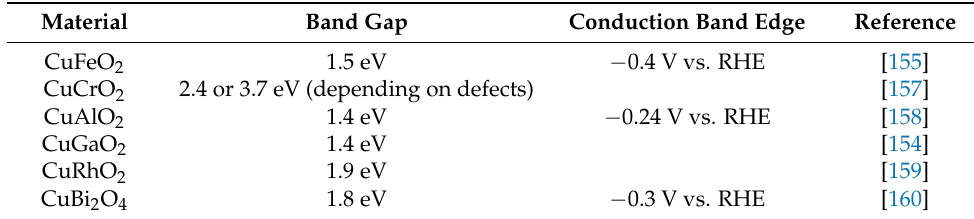
Table 5. Electronic properties of copper-based ternary